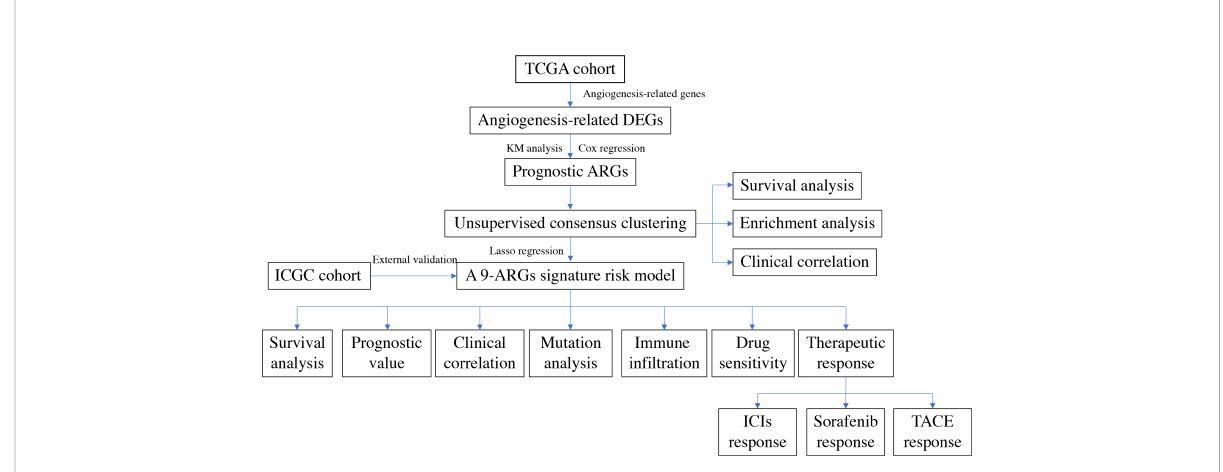
FIGURE 1 The fl owchart of the entire